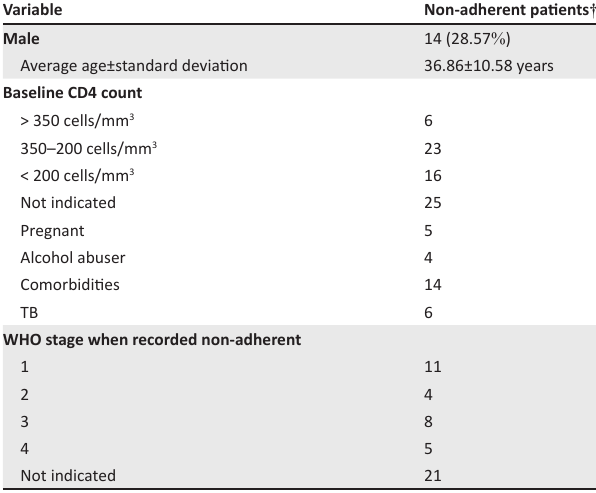
TABLE 2: Characteristics of non-adherent patients.